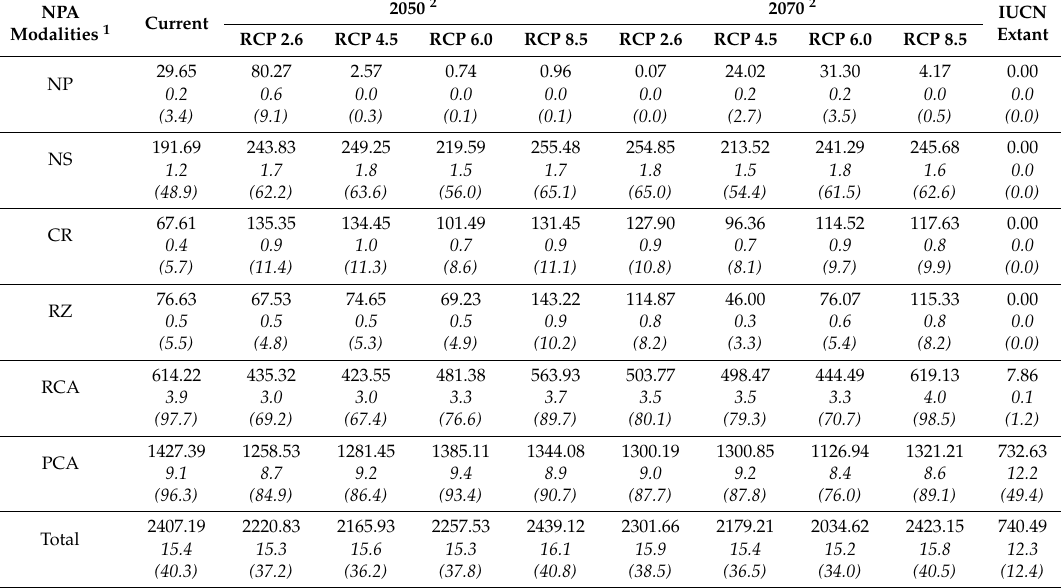
Table 6. Area (in km 2 and %) of the total potential distribution predicted both in current conditions and in climate change scenarios of the spectacled bear that was protected by the modalities of Protected Natural Area in Amazonas